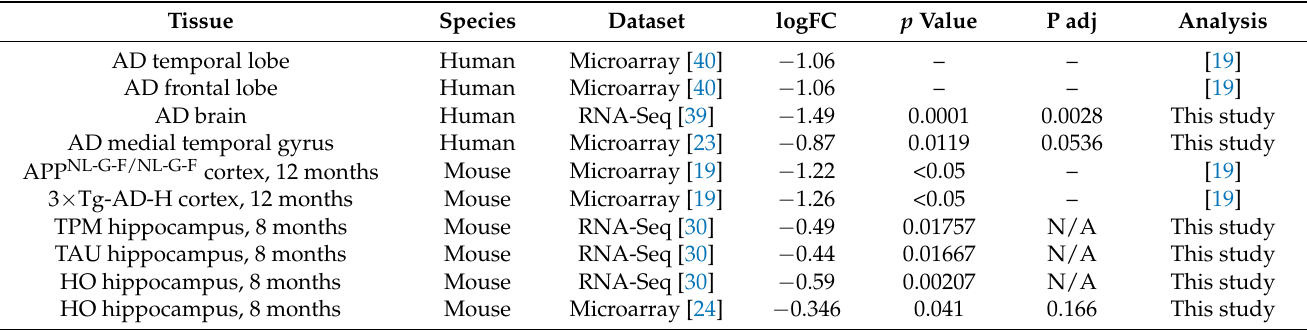
Table 1. Willin/ FRMD6 expression in microarray and RNA-Seq datasets from AD patients and AD mouse